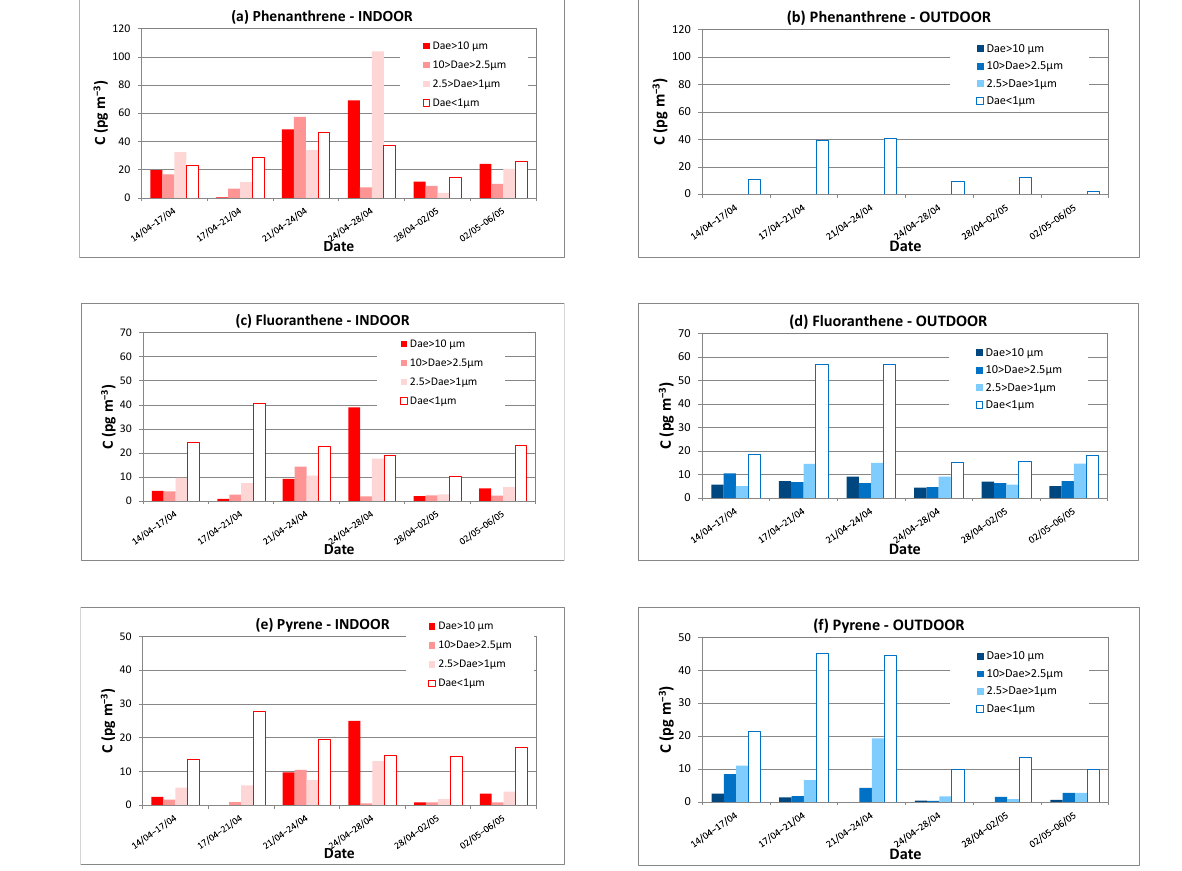
Figure 5. Indoor and outdoor concentrations (pg m − 3 ) of PAHs with three or four rings measured in 2014 vs. time and particle size. ( a ) Phenanthrene, indoors; ( b ) Phenanthrene, outdoors; ( c ) Fluoranthene, indoors; ( d ) Fluoranthene, outdoors; ( e ) Pyrene, indoors; ( f ) Pyrene, outdoors.